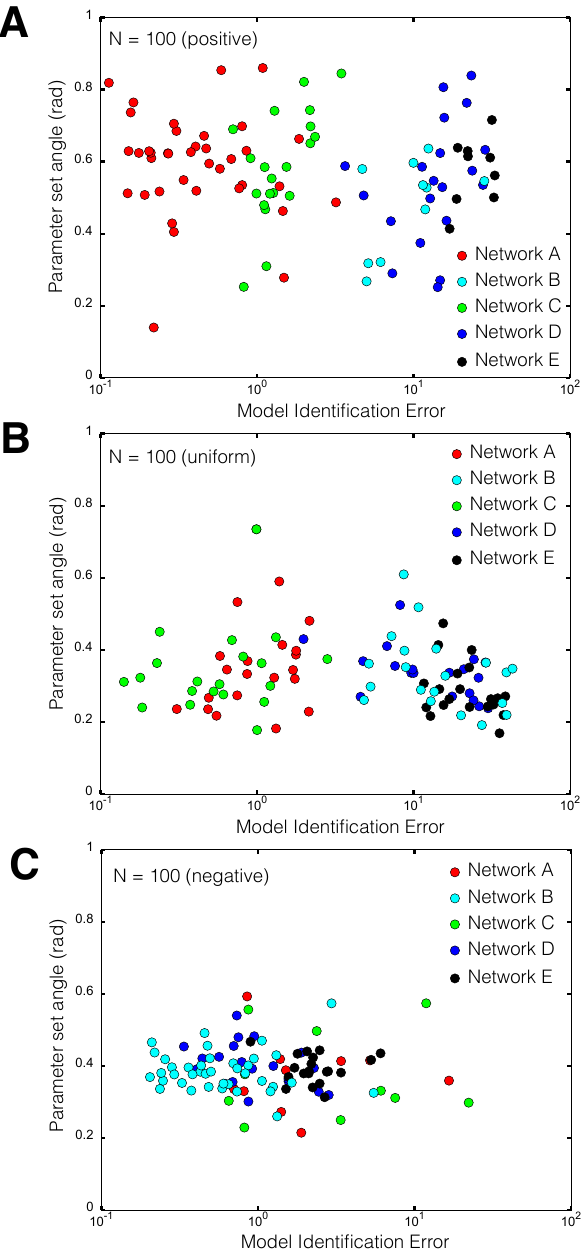
Figure 7. Combined control and kinetic parameter search using modified particle swarm optimization (PSO). A population of 100 particles was initialized with randomized kinetic parameters and one of five possible control configurations (Network A–E). Simulation error was minimized for a synthetic data set ( S , end product P and intermediate M 1 5 sampled approximately every 20 min) generated using Network A. ( A ) Simulation error versus parameter set angle for 100 particles biased toward the correct regulatory program (A,B,C,D,E) = (40%, 10%, 20%, 20% and 10%); ( B ) Simulation error versus parameter set angle for 100 uniformly distributed particles (A,B,C,D,E) = (20%, 20%, 20%, 20% and 20%); ( C ) Simulation error versus parameter set angle for 100 negatively biased particles (A,B,C,D,E) = (10%, 40%, 10%, 20% and 20%). Network A (the correct structure) was preferentially identified for positively and uniform biased particle distributions, but misidentified in the presence of a large incorrect